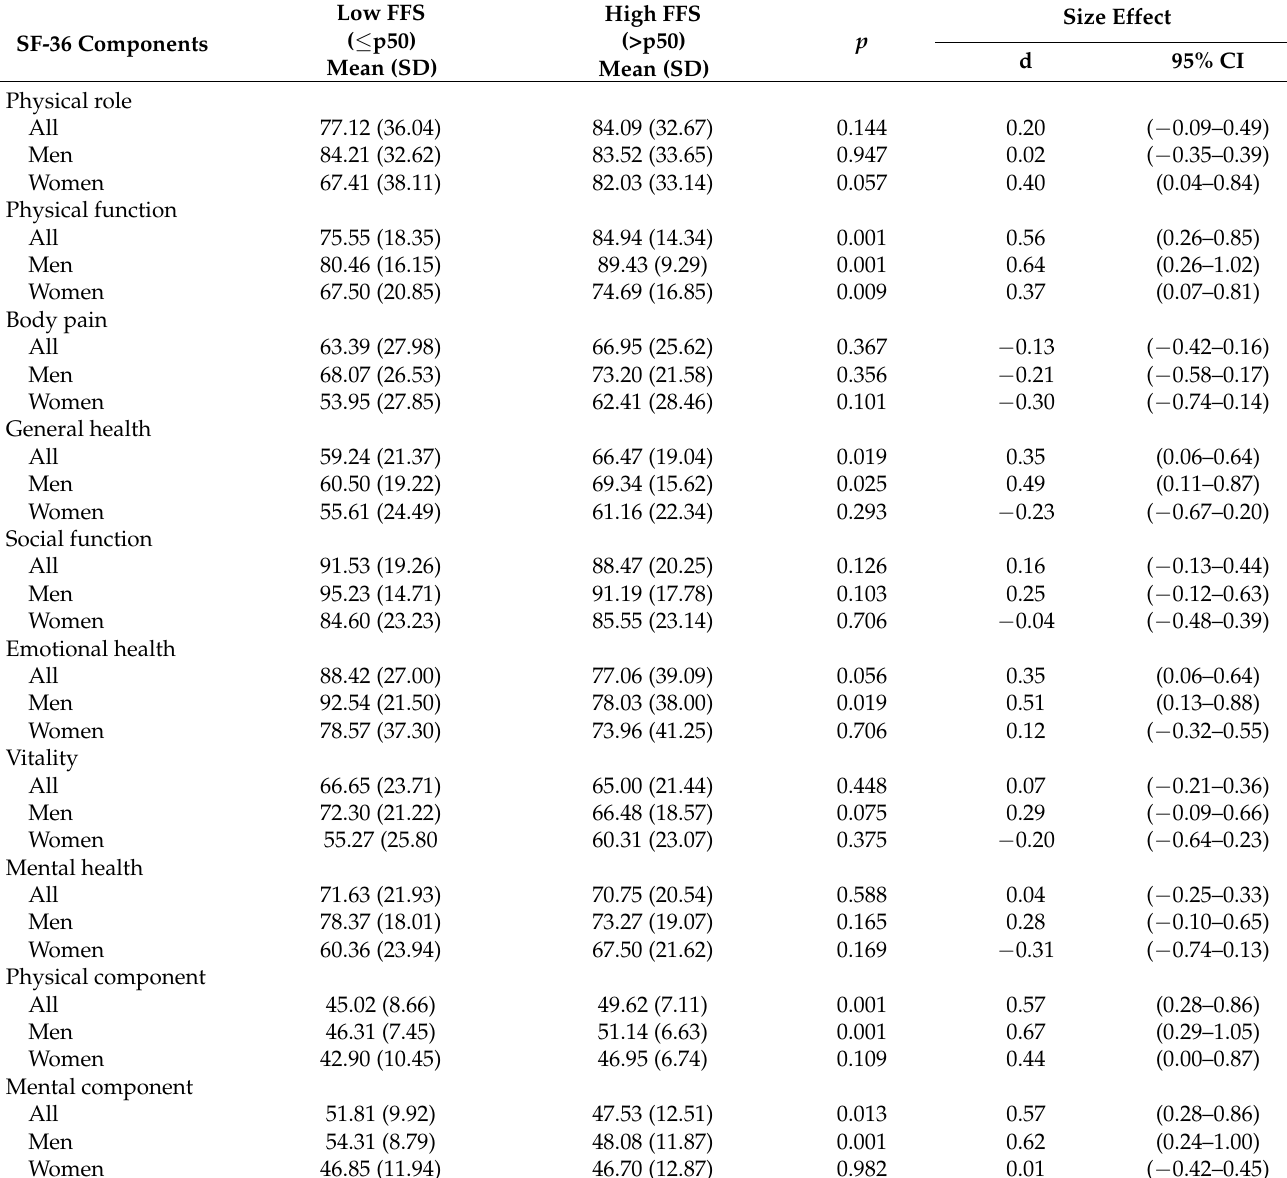
Table 5. Association between functional fitness score and SF-36